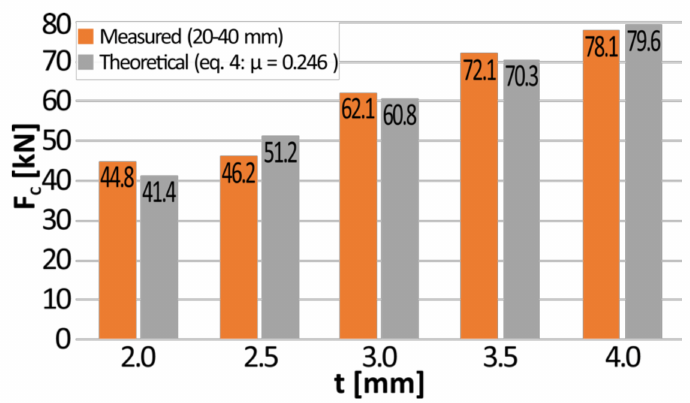
Figure 6. The comparison of calculated and measured crushing force.